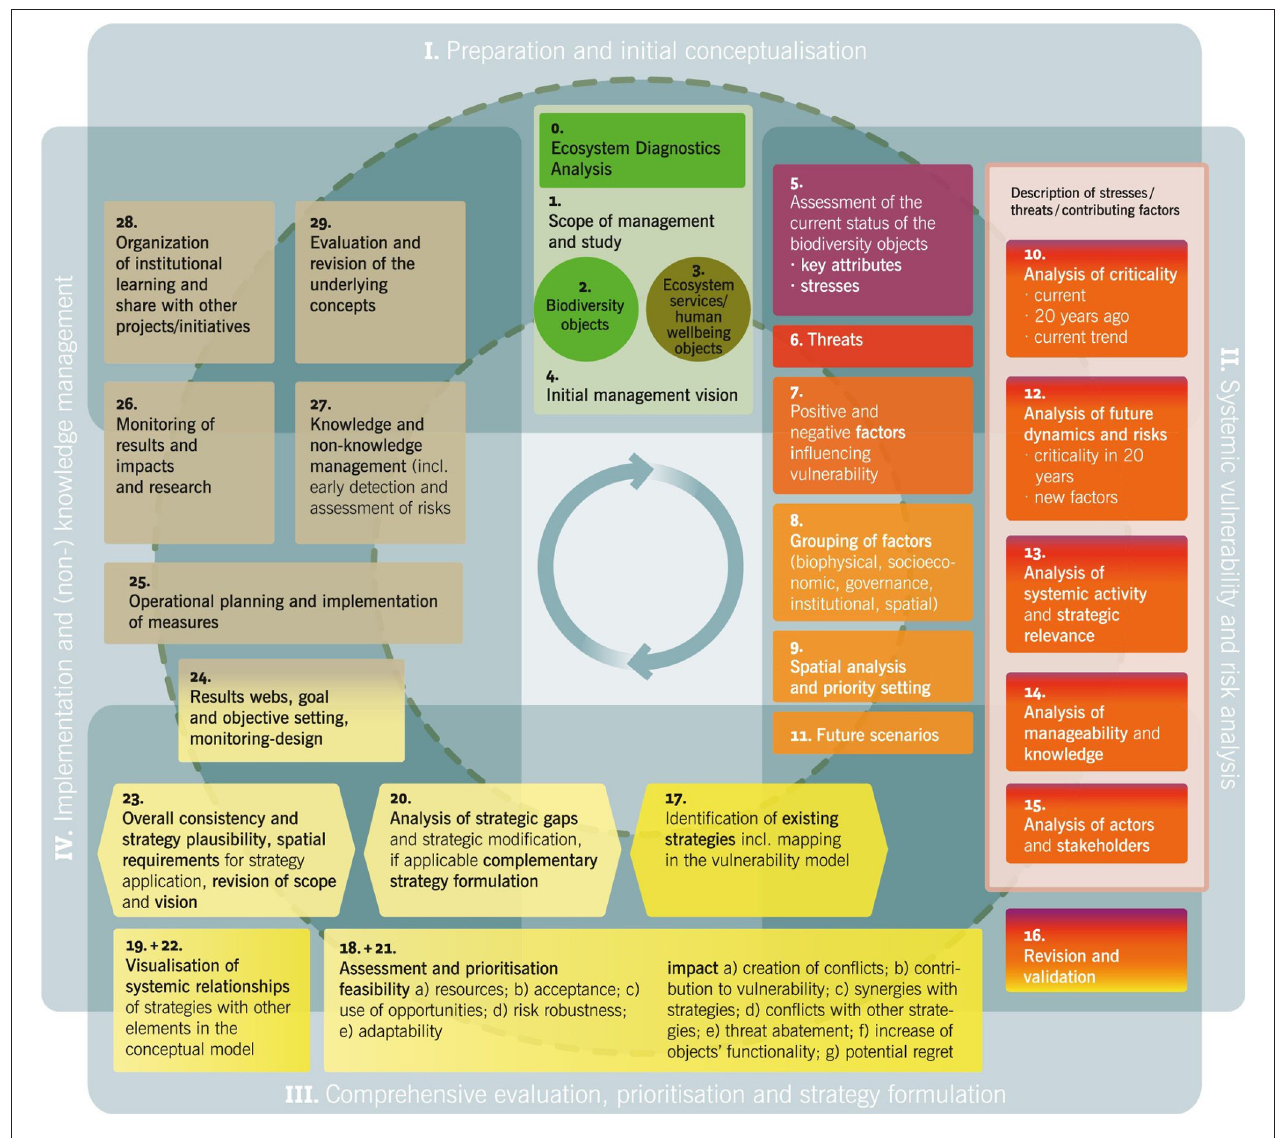
FIGURE 1 | The four phases of the MARISCO cycle: (i) preparation and initial conceptualization, (ii) systemic vulnerability and risk analysis, (iii) comprehensive evaluation, prioritization and strategy formulation, and (iv) Implementation and (non-)knowledge management. See Figure 3 for an indication of the steps applied during our participatory assessment in